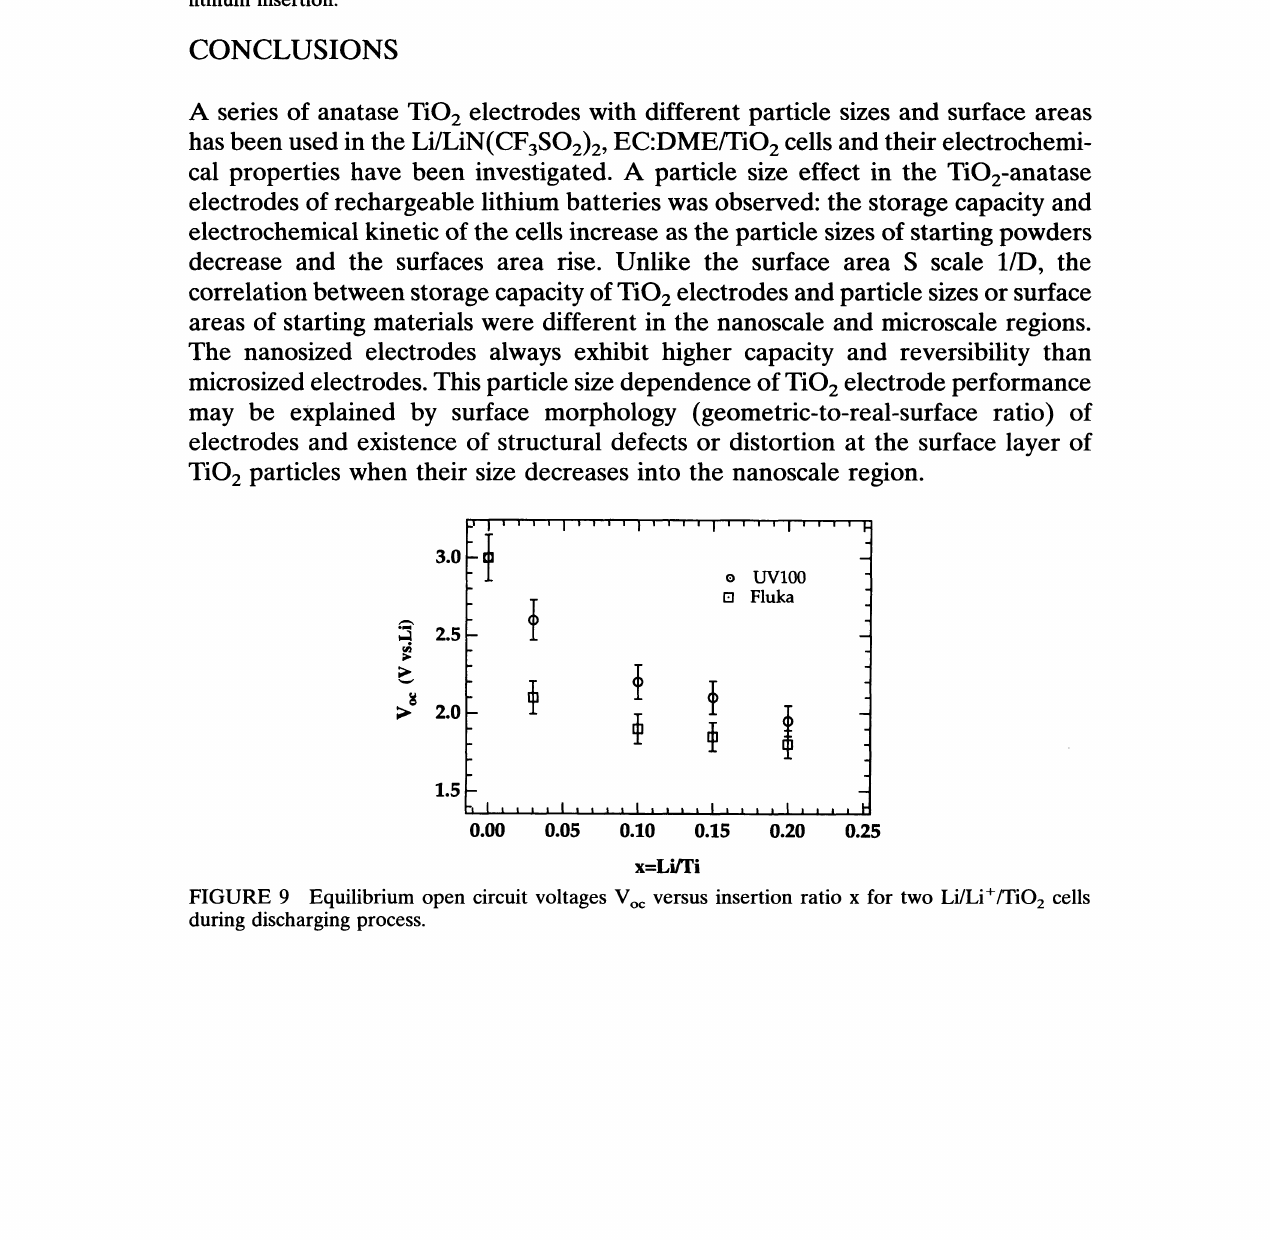
FIGURE 8 Decrease of the size of crystallite upon lithium insertion: (1) well crystallized remaining region of composition LixTiO; (2) amorphous region of composition Li,,’TiO2 (x’ > x), formed during lithium insertion, d d’ Adhk illustrates the enlargement of the X-ray diffraction peaks due to the lithium insertion.